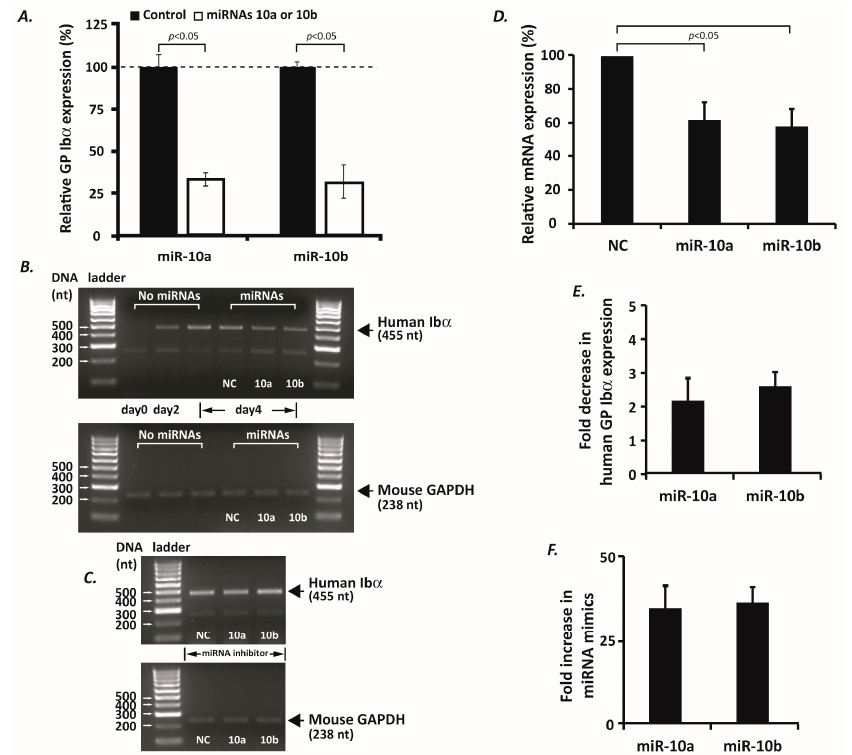
Figure 2. miR-10a and -10b inhibit the expression of human GP Ib α . Either miR-10a or -10b mimics (80 nM) were co-transfected with 0.5 µg of pDX-hGP Ib α plasmid DNAs, a human GP Ib α expression construct containing both coding and 3 ′ -UTR sequences of the human GP1BA gene, into β /IX-expressing Chinese Hamster Ovary (CHO) cells. Two days after transfection, the transient expression levels of GP Ib α in these cells were measured by flow cytometry with a human GP Ib α -specific mouse monoclonal antibody and a fluorescein isothiocyanate (FITC)-labeled anti-mouse secondary antibody. Mean fluorescence intensities of the miR-10a/b mimic-transfected cells were normalized to that of the negative control miRNA mimic-transfected cells ( A ); Standard errors ( ± SEM) were calculated from three independent experiments. A half million murine lineage negative cells were transfected with 80 nM of miR-10a or -10b or negative control (NC) miRNA mimics, and then treated with a mixture of megakaryocyte differentiation-inducing cytokines as described in the Materials and Methods. In the 4-day period after transfection and megakaryocyte differentiation, the human GP Ib α mRNA expression levels were examined either by reverse transcription polymerase chain reaction (RT-PCR) ( B ) followed by densitometry analysis using Image J software (version 1.48) ( D ), or by quantitative PCR ( E ). Neither miR-10a nor -10b inhibitors increase the expression levels of human GP Ib α mRNA at day 2 ( C ). In addition, the expression levels of miRNA mimics transfected into the cells at day 4 were quantified by qPCR as well ( F ). The Student t test and analysis of variance were used to assess differences. p < 0.05 is considered as